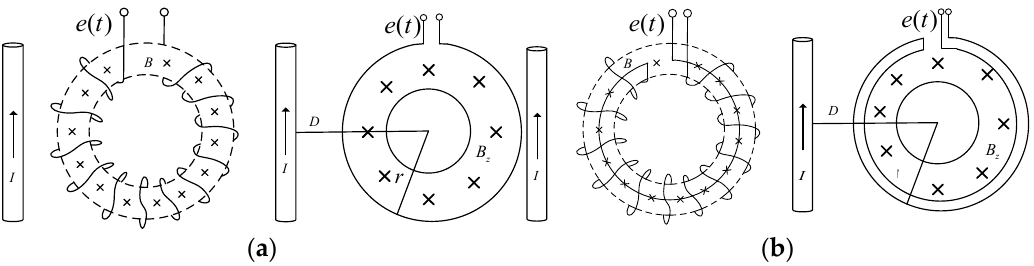
Figure 3. Diagram of interference of external vertical magnetic field on coil. ( a ) Equivalent large turn without return line; ( b ) Rogowski coil with the return line. When the interference magnetic field is parallel to the coil plane, the interference magnetic field produces two opposite induced voltages on the left and right sides of the coil. According to the external magnetic line and the spatial geometric position of the Rogowski coil, the structure diagram is drawn. The left side of the coil is shown in Figure 4a, and the right side of the coil is shown in Figure 4b.